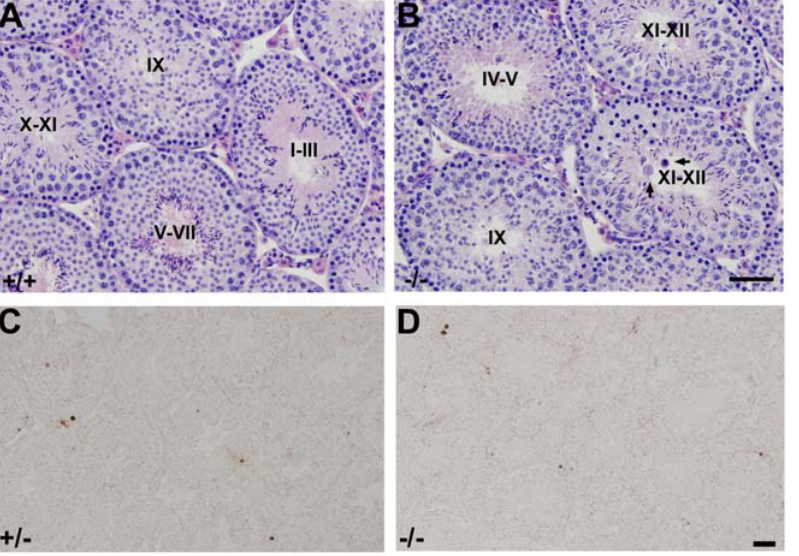
Figure 2. Histological analysis and TUNEL staining of testicular sections of mutant testes. Hematoxylin- and eosin-stained cross-sections of heterozygous (A) or homozygous mutant (B) testes from adult mice are shown. Greek numerals indicate the stages of seminiferous tubules, as defined by Russell et al. [18]. Morphologically normal spermatogenesis rarely occurred in the mutant testes. Arrowheads indicate a few germ cells located irregularly at the luminal region of the mutant seminiferous tubules. TUNEL staining of cross-sections of heterozygous (C) or homozygous mutant (D) testes from adult mice are shown. Apoptotic signals were rarely observed in the heterozygous and homozygous mutant testes. Bar=50 m